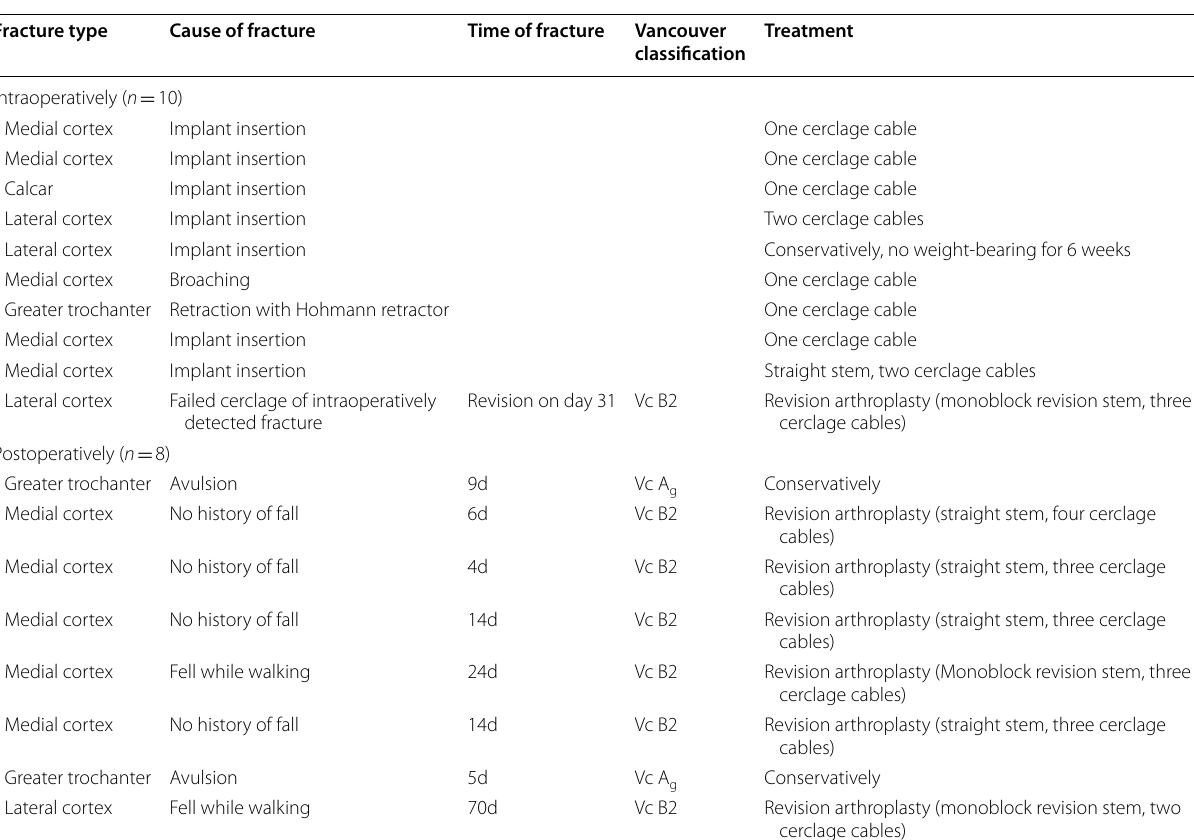
Table 3 Cause of fracture, time of fracture, Vancouver classification, and treatment for all